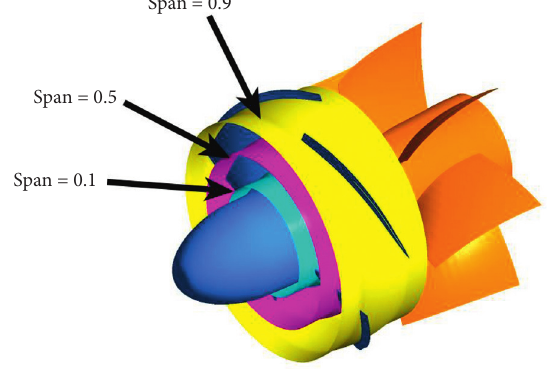
Figure 11: Span distribution.